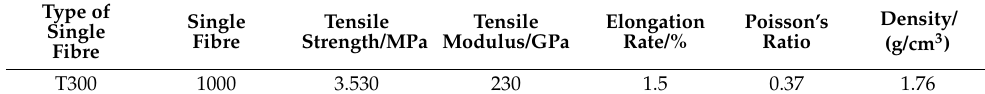
Figure 12. Types of cracks in the tunnel lining.